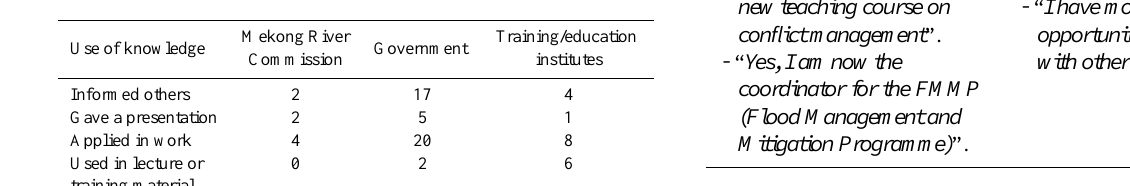
Table 8. Use of knowledge gained, per organisation type (multiple answers allowed) ( n = 37).